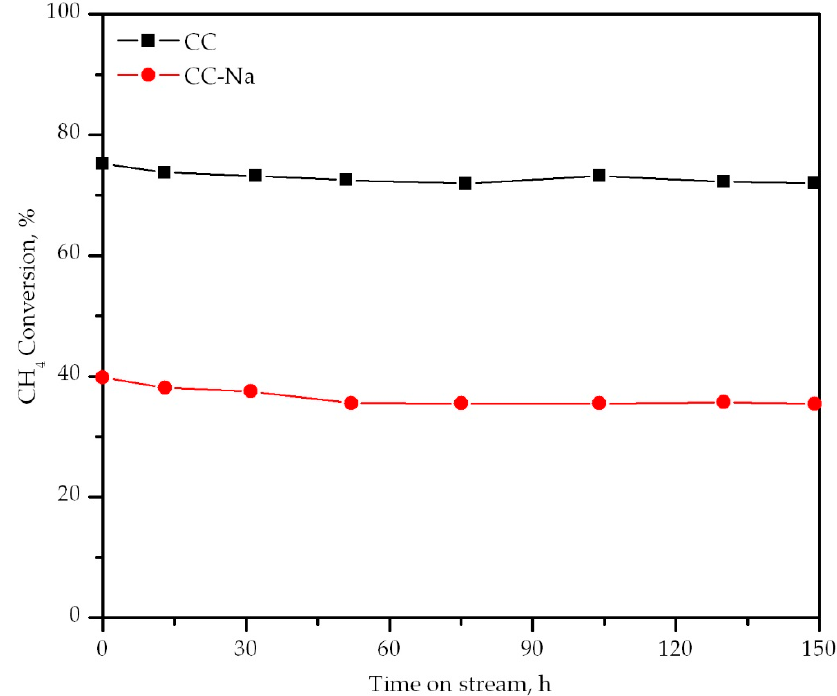
Figure 10. Stability of the catalysts over time.